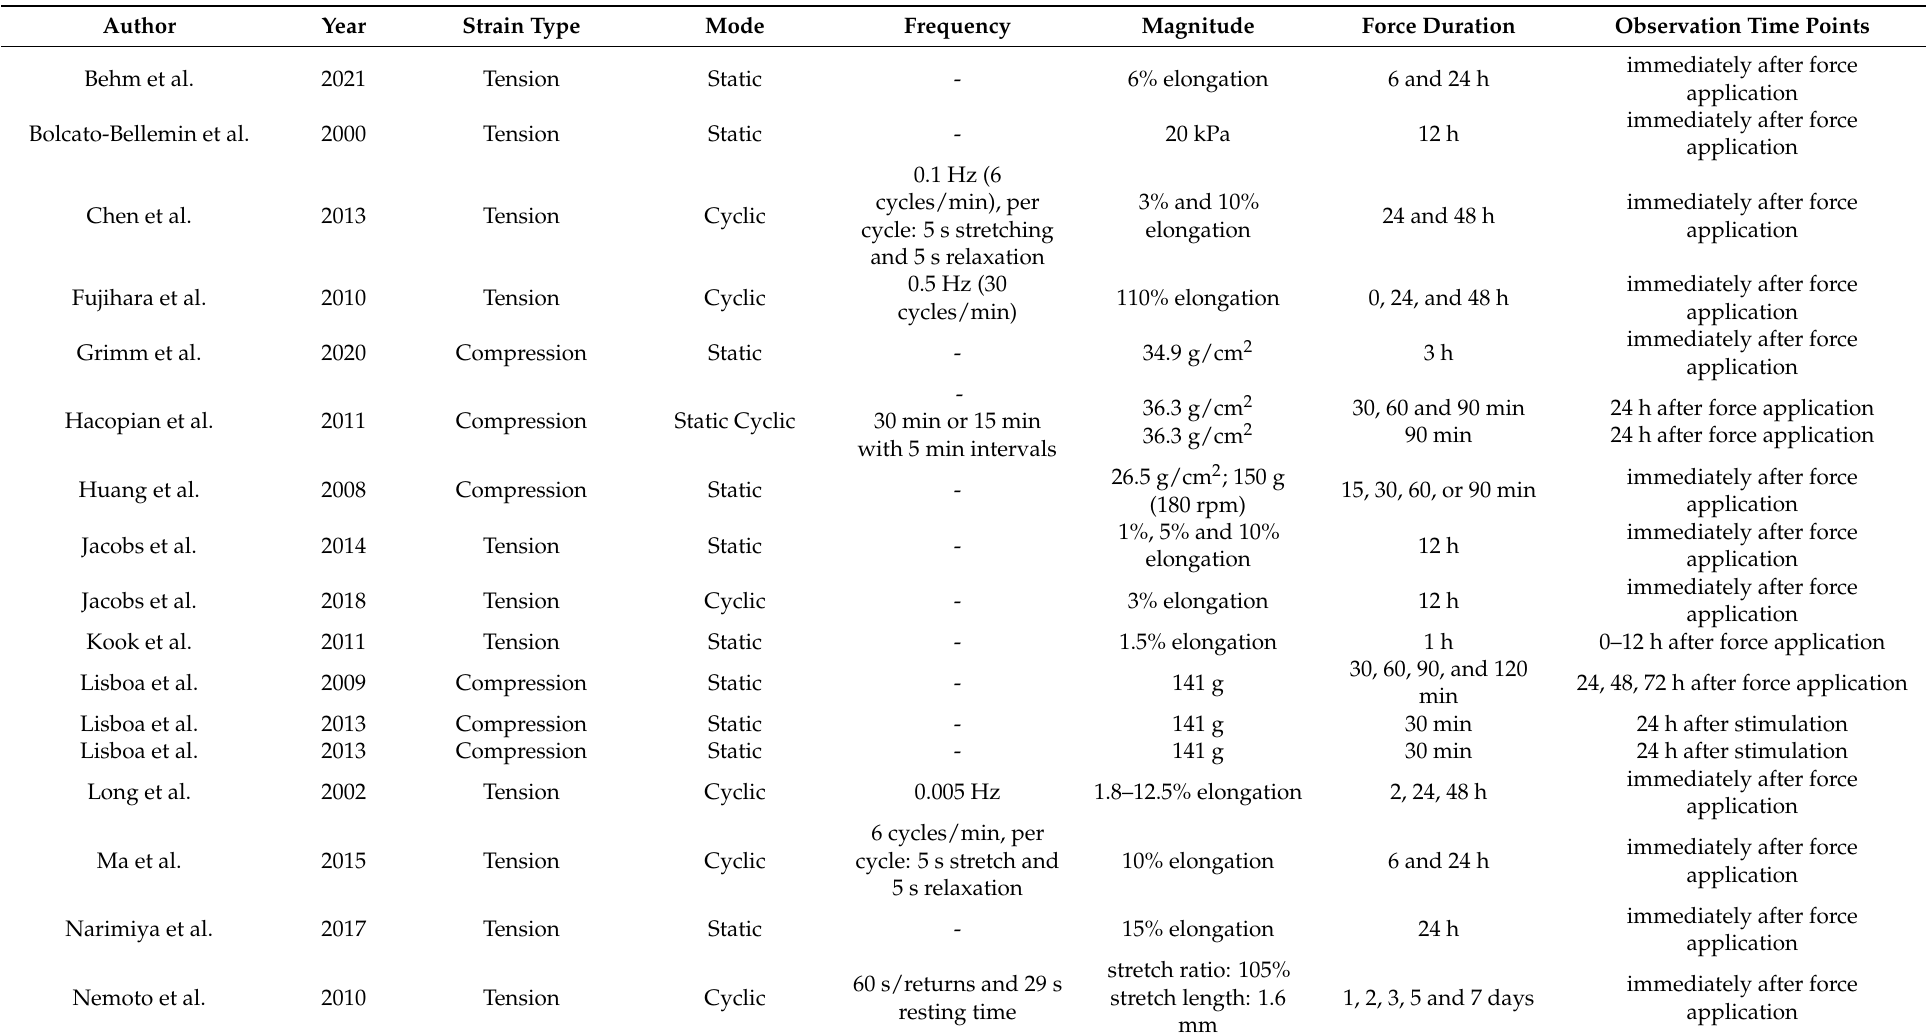
Table 2. Intervention parameters of all included in vitro